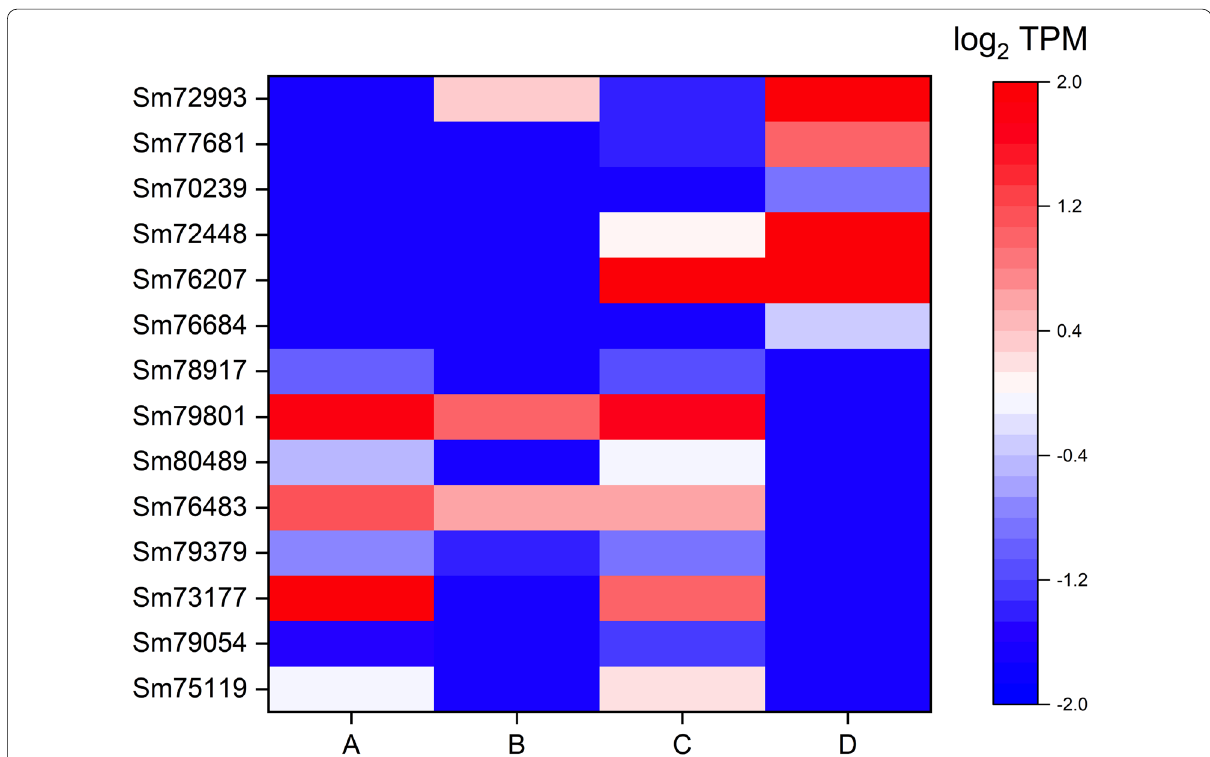
Fig. 3 Heat map of 14 transcripts of S. mycoparasitica with/without the host F. graminearum at different incubation times (1.5 and 3.5 days). Colors from blue to red indicate that the transcript levels expressed as log 2 TPM values from low to high. Each column represents each sample group (A, S.m. 1.5 days; B, S.m. 1.5 days interaction with F.g. 3-ADON; C, S.m. 3.5 days; D, S.m. 3.5 days interaction with F.g.